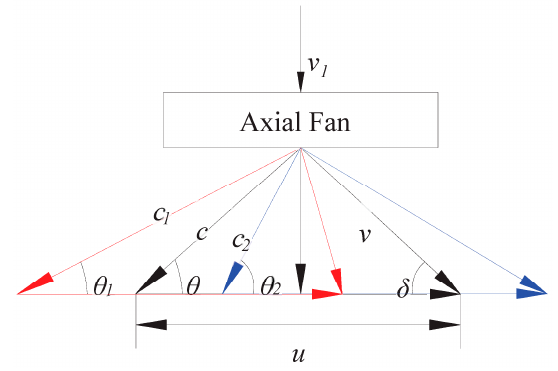
Figure 16. The airflow velocity triangle.